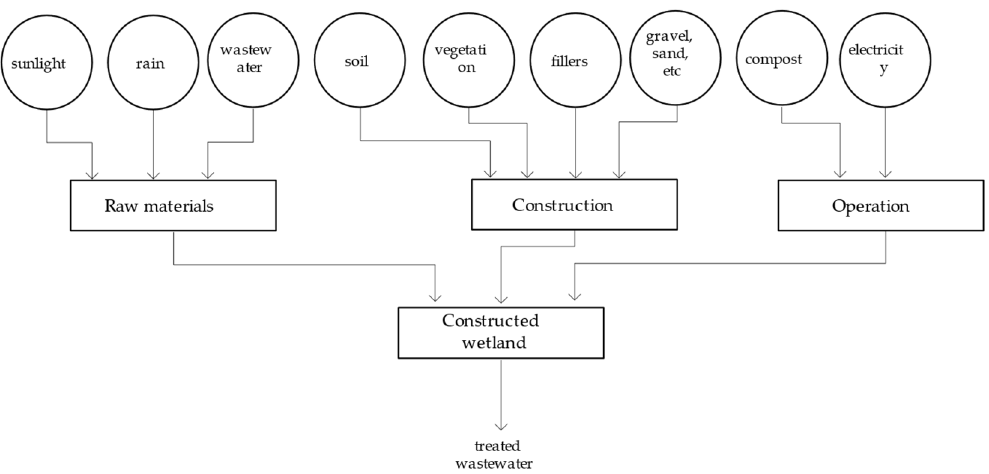
Figure 5. System diagram of the constructed wetland system.